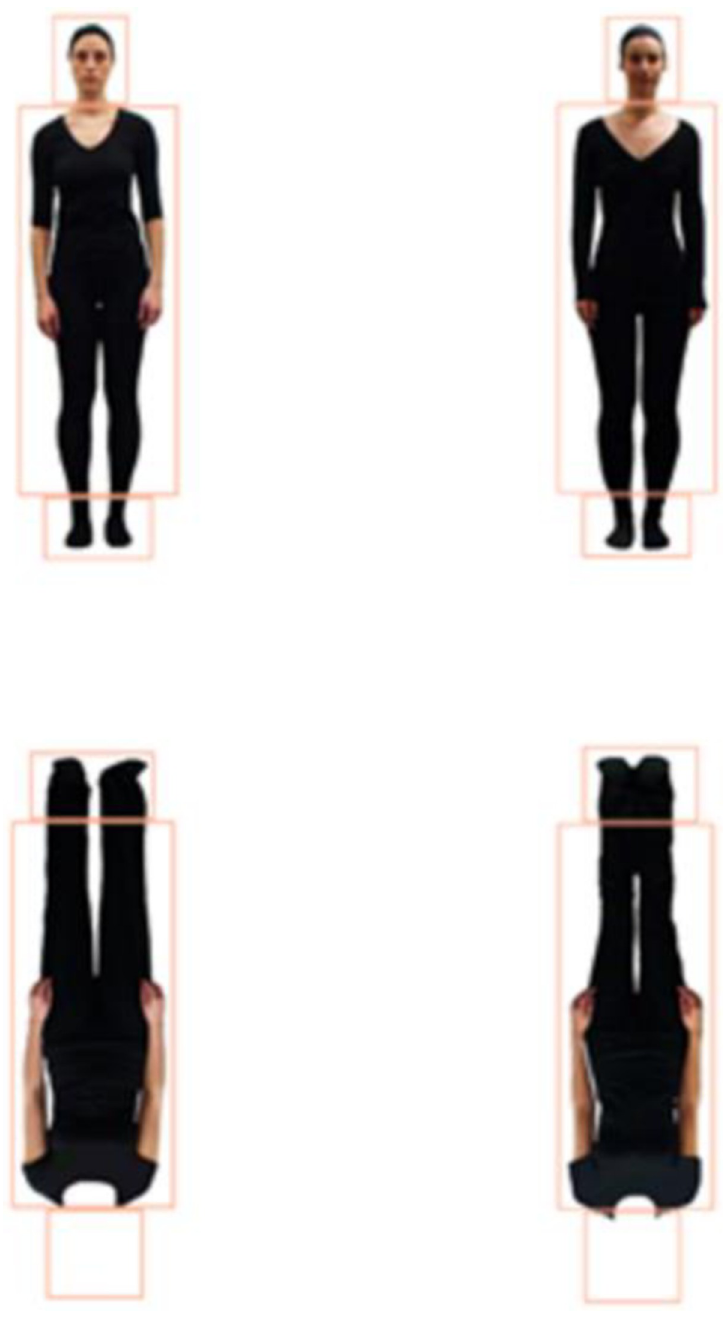
Fig 1. Identity task whole figure upright (WFU) pair and headless inverted (HLI) pair along with interest areas (IAs) surrounding the heads, bodies, and feet. and Coltheart [2], the figures in each pair wore similar clothing (e.g., short or long sleeves) and had similar body shapes to enhance the likelihood that identity discrimination would be based on identity and less on clothing and body shape. The average size of the whole figures was 4.96˚ × 12.50˚ visual angle at 900mm distance and the headless figures were 4.96˚ × 10.82˚.